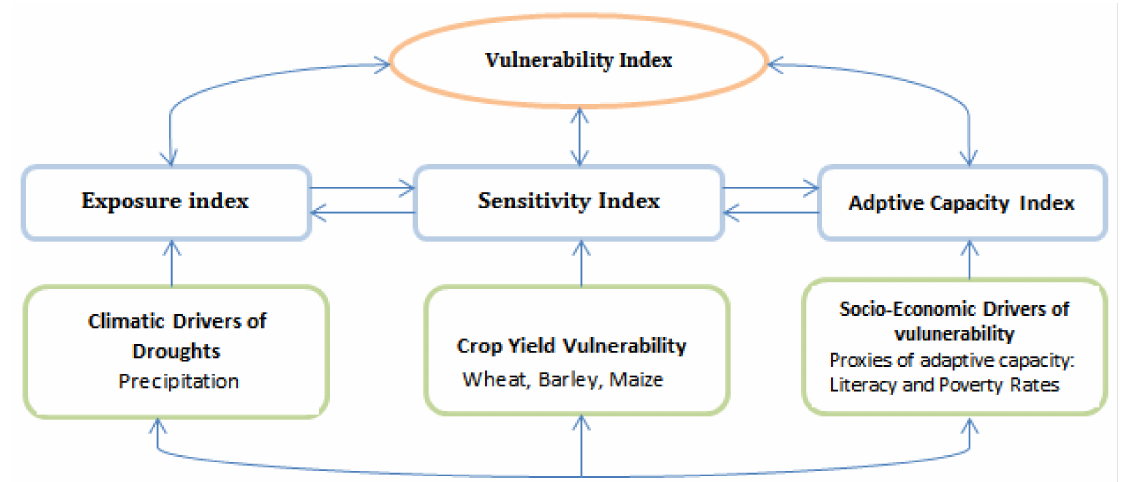
Figure 1. The conceptual framework of